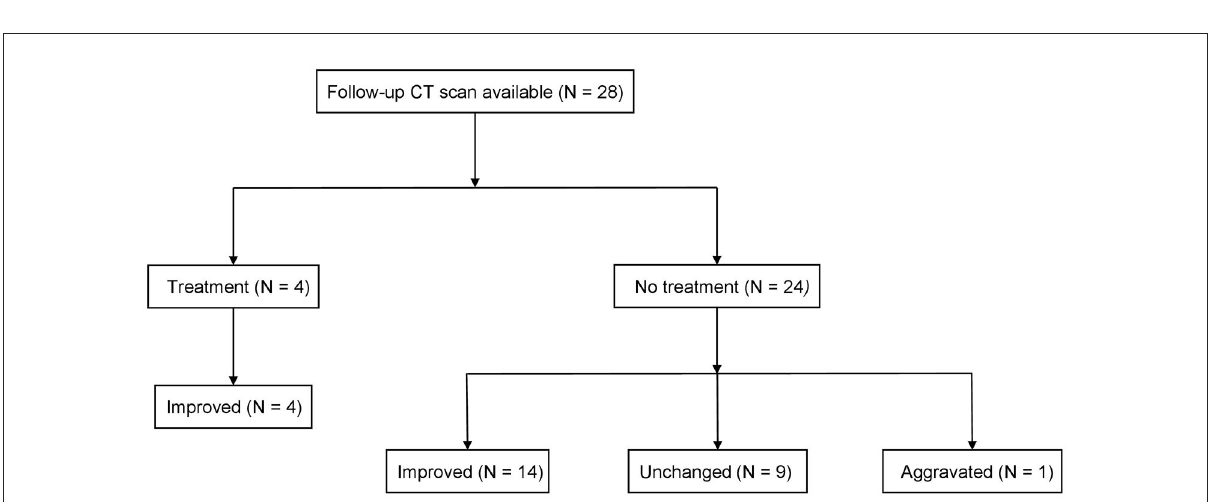
FIGURE3 Clinical course of the patients with SLR. Patients who received treatment were given prednisolone with a mean dose of 28.8mg. Improvements were defined as a decrease in the sum of the lengths of SLR lesions by 30% or more. Aggravation was defined as an increase in the sum of the lengths of SLR lesions by 20% or more. SLR, sarcoid-like